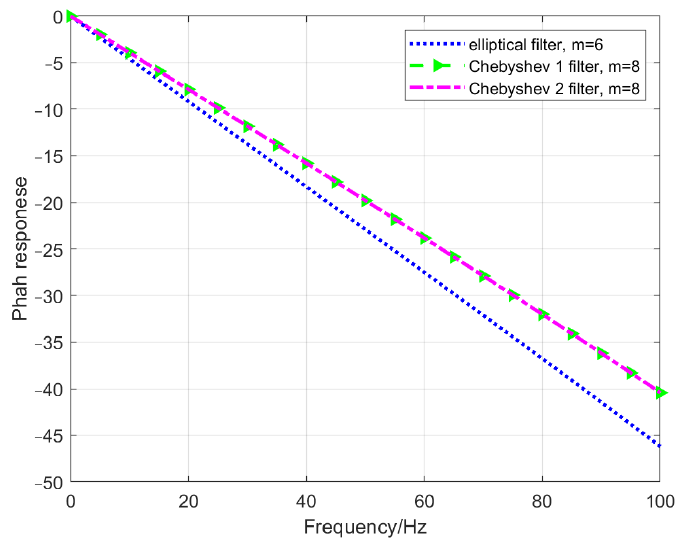
Figure 8. Phase response comparison of various types of filters (0 Hz~100 Hz).